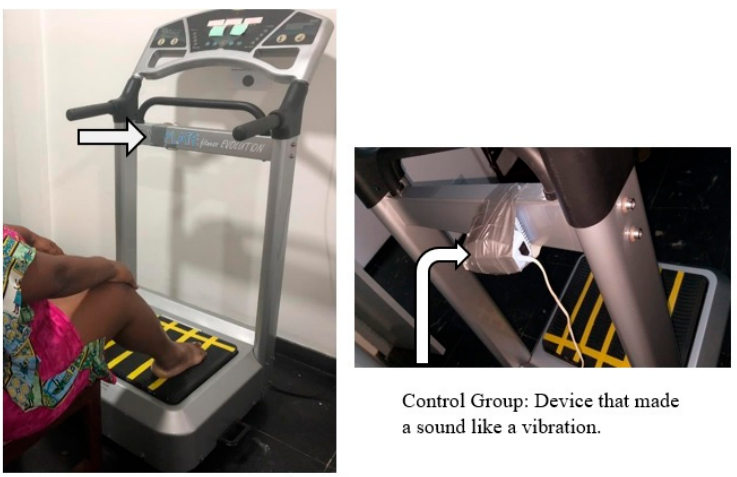
Figure 4. Control group intervention.